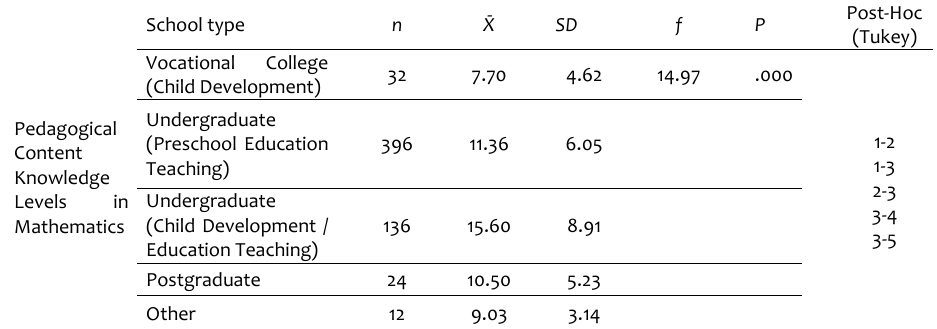
Table 3. Distribution of teachers’ pedagogical content knowledge levels in mathematics by graduation school type